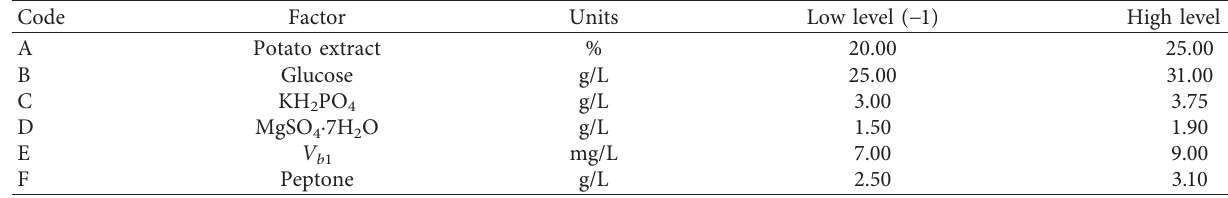
Table 2: Experimental level of the Plackett–Burman design.